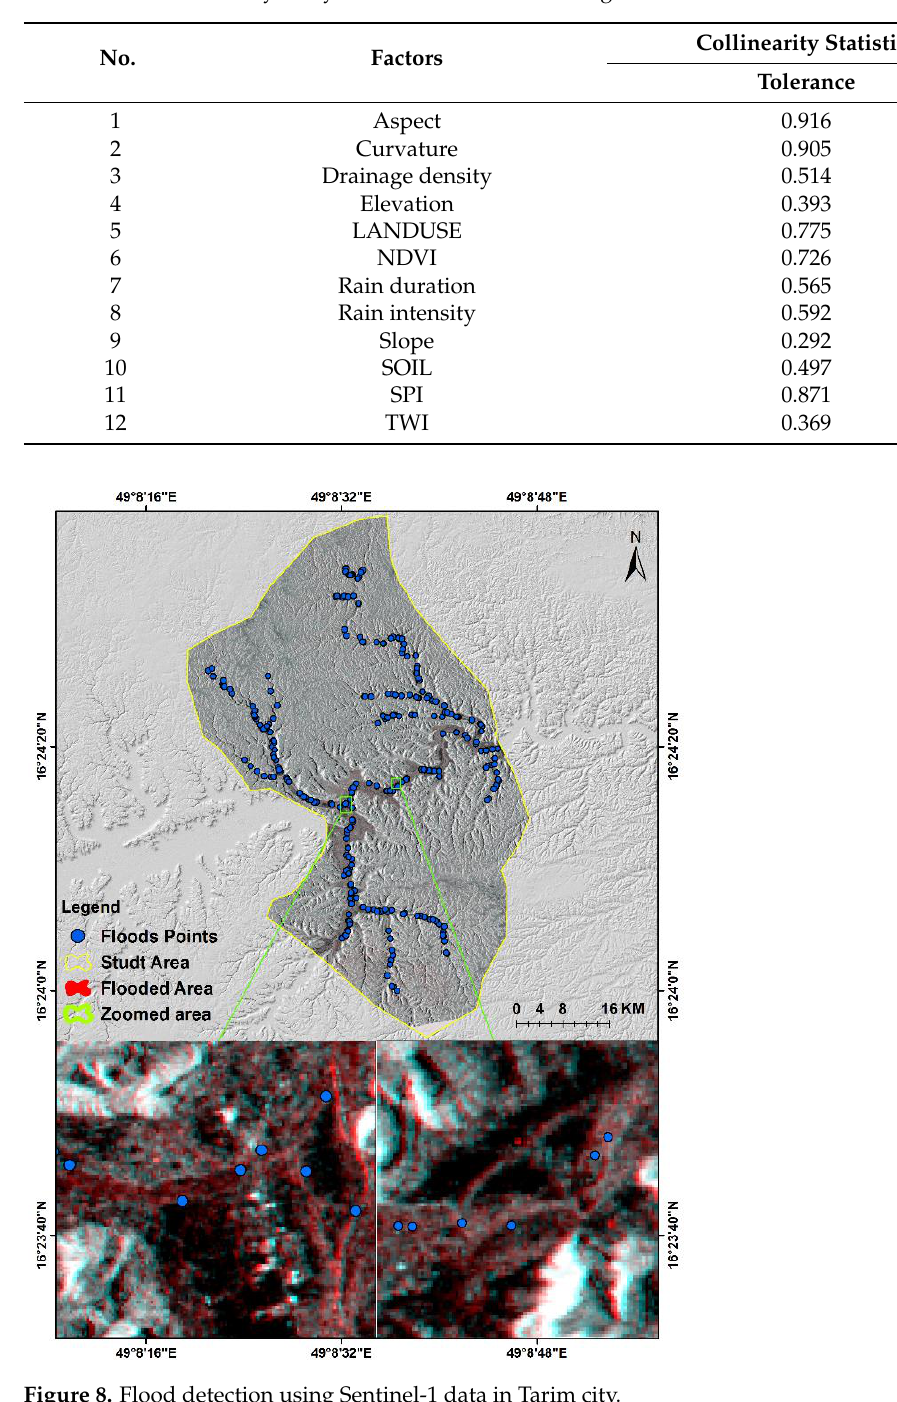
Table 3. Multicollinearity analysis of the flood conditioning factors.